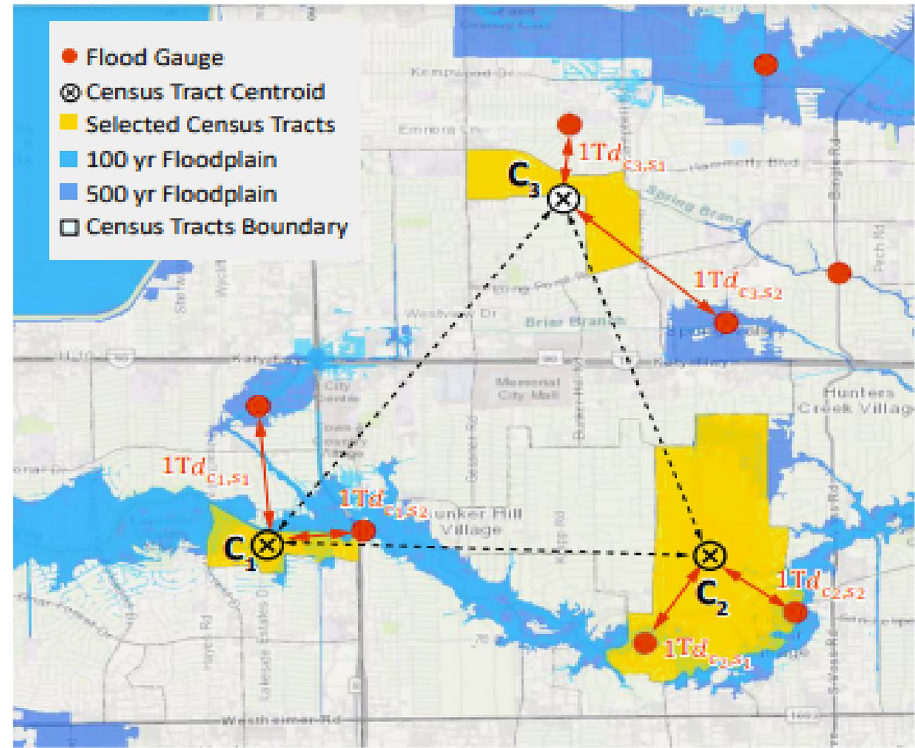
Figure 3. Schematic illustration of calculating census tracts’ distances and weights of two closest flood gauges as inputs to the census tract physic-based